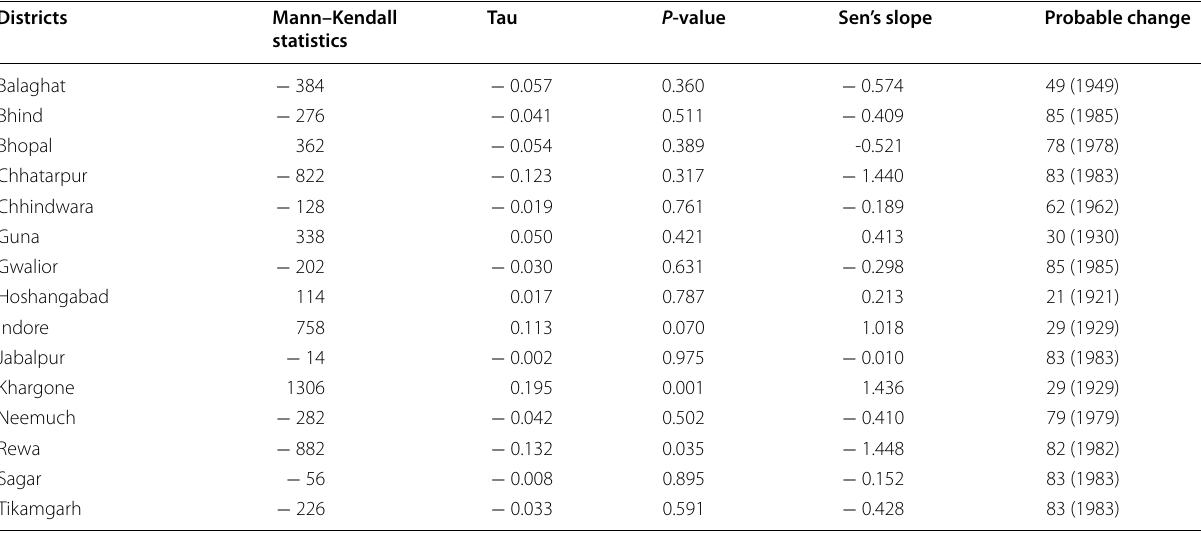
Table 2 The trend in annual precipitation of 115 years (1901–2016) in the 15 districts of Madhya Pradesh state of central India selected for study as per Mann–Kendall test and Sen’s estimator indicating a non-significant change in long-term trend at all the studied districts of Madhya Pradesh except for the Khargone and Rewa districts